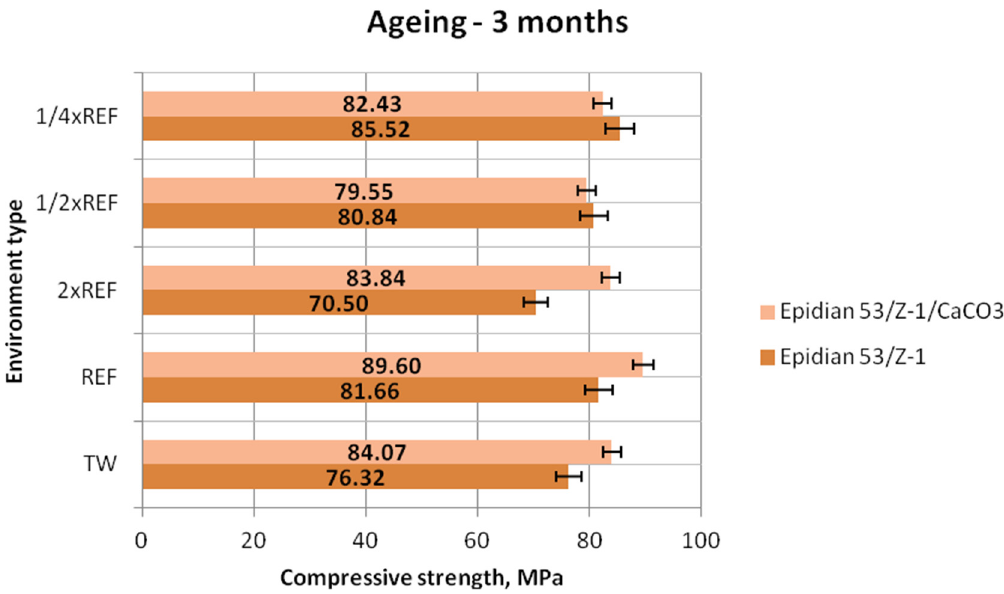
Compressive strength of the unmodified (Epidian 53 / Z-1) and modified (Epidian 53 / Z-1 / CaCO 3 ) adhesive compounds, aged for 3 months.